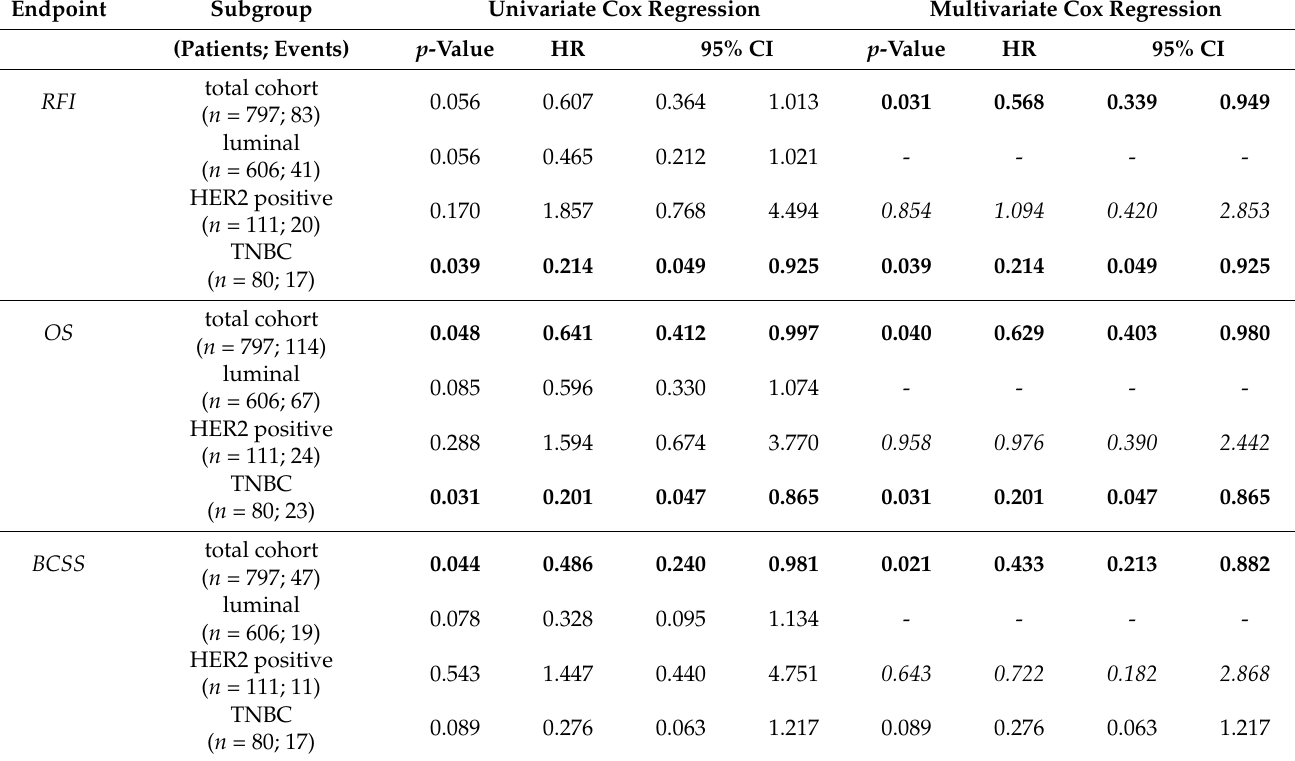
Table 1. Prognostic impact of the FTNB-173 promoter polymorphism rs3215788 (6G > 5G) for genotype 6/5 vs. 6/6 in univariate und multivariate analyses of RFI, OS and BCSS. Univariate Cox Regression Multivariate Cox